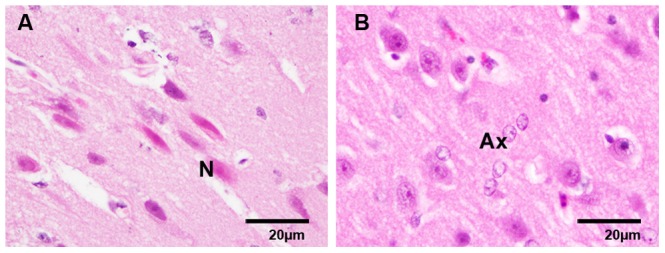
Histopathology.‘Red neurons’ (A) and astrocytic nuclear swelling (B). H&E ×400. N, neuron; Ax, axon.